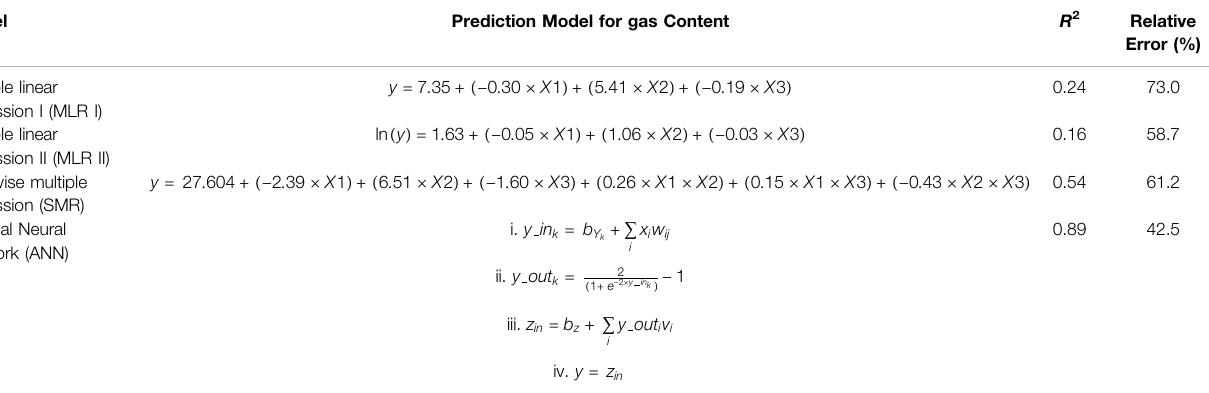
TABLE 3 | Summary of the three statistical models (MLR I, MLR II, and SMR) and the data driven model (ANN) tested for the prediction of sediment gas content ( y ) from the variables X 1=waterdepth, X 2=sedimentthickness, and X 3=LOIat550 ° C.ForthetrainedANN y in k denotestheinputvalueforneuron Y k , b Y k isthebiasofneuron Y k of the hidden layer, and x i is the value of the predictor i . y out k is the value calculated by the transfer function and b z is the bias of the output neuron. w ij , and v i are the weights of the neurons connecting the input to the hidden layer and the hidden layer to the output neuron,